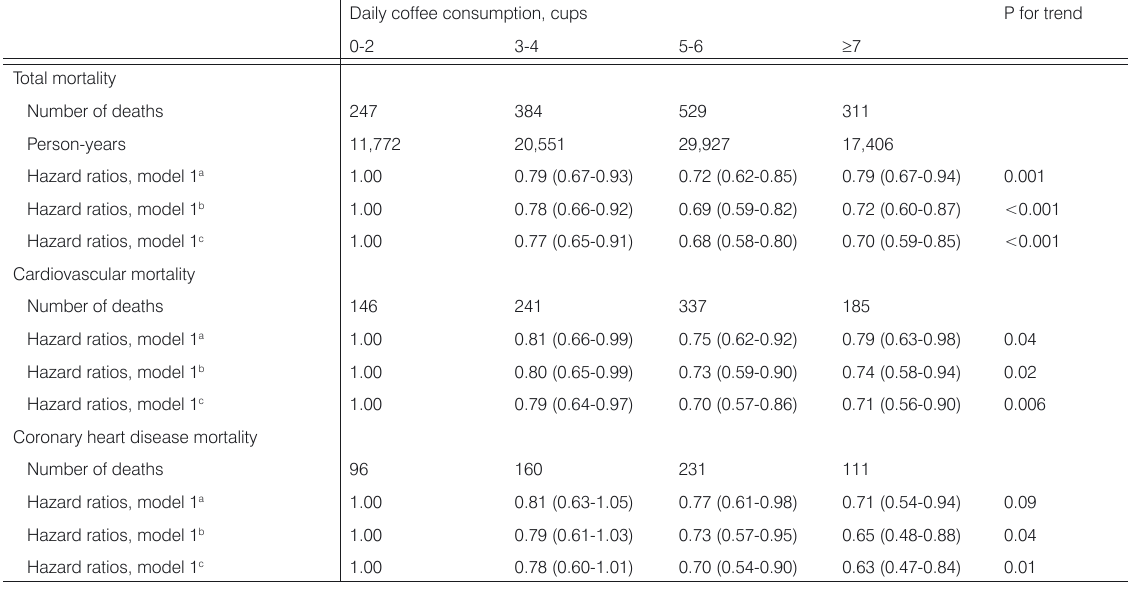
Table 6. Hazard ratios (95% CIs) of total, cardiovascular, coronary heart disease, and stroke mortality by volume of coffee consumption among subjects with type 2 diabetes